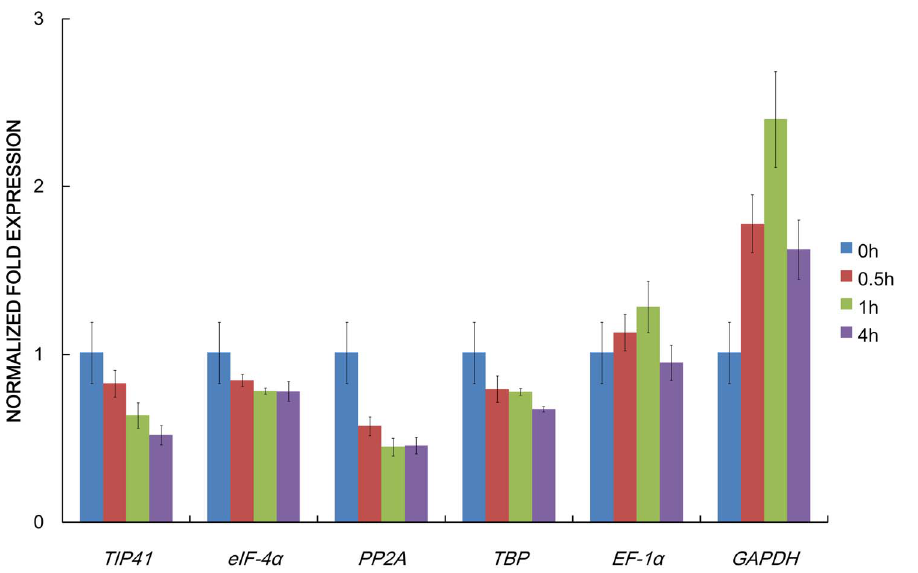
Figure 3. Relative quantification of M6PR gene expression using validated reference genes for normalization under salt treatment in O.javanica .